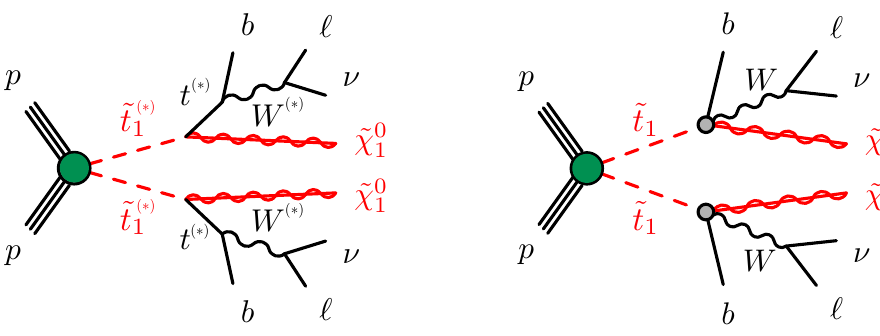
b ˜  ± 1 decay (a) two-body Figure 2 . The left diagram illustrates the MG scheme for the parameter space where m (~ t 1 ) naming conventions). The green circles represent the full tree-level stop pair production matrix element. The gray circles represent decays that do not include any matrix element information, i.e., the particles are decayed using phase space alone. The superscripts ( can go o(cid:11) shell. This (cid:12)gure was adapted from the diagrams in [14]. distribution functions [34], and Pythia 8.2 [35] is always used for the parton shower and hadronization. The stop pair production cross section is calculated using NLLFast